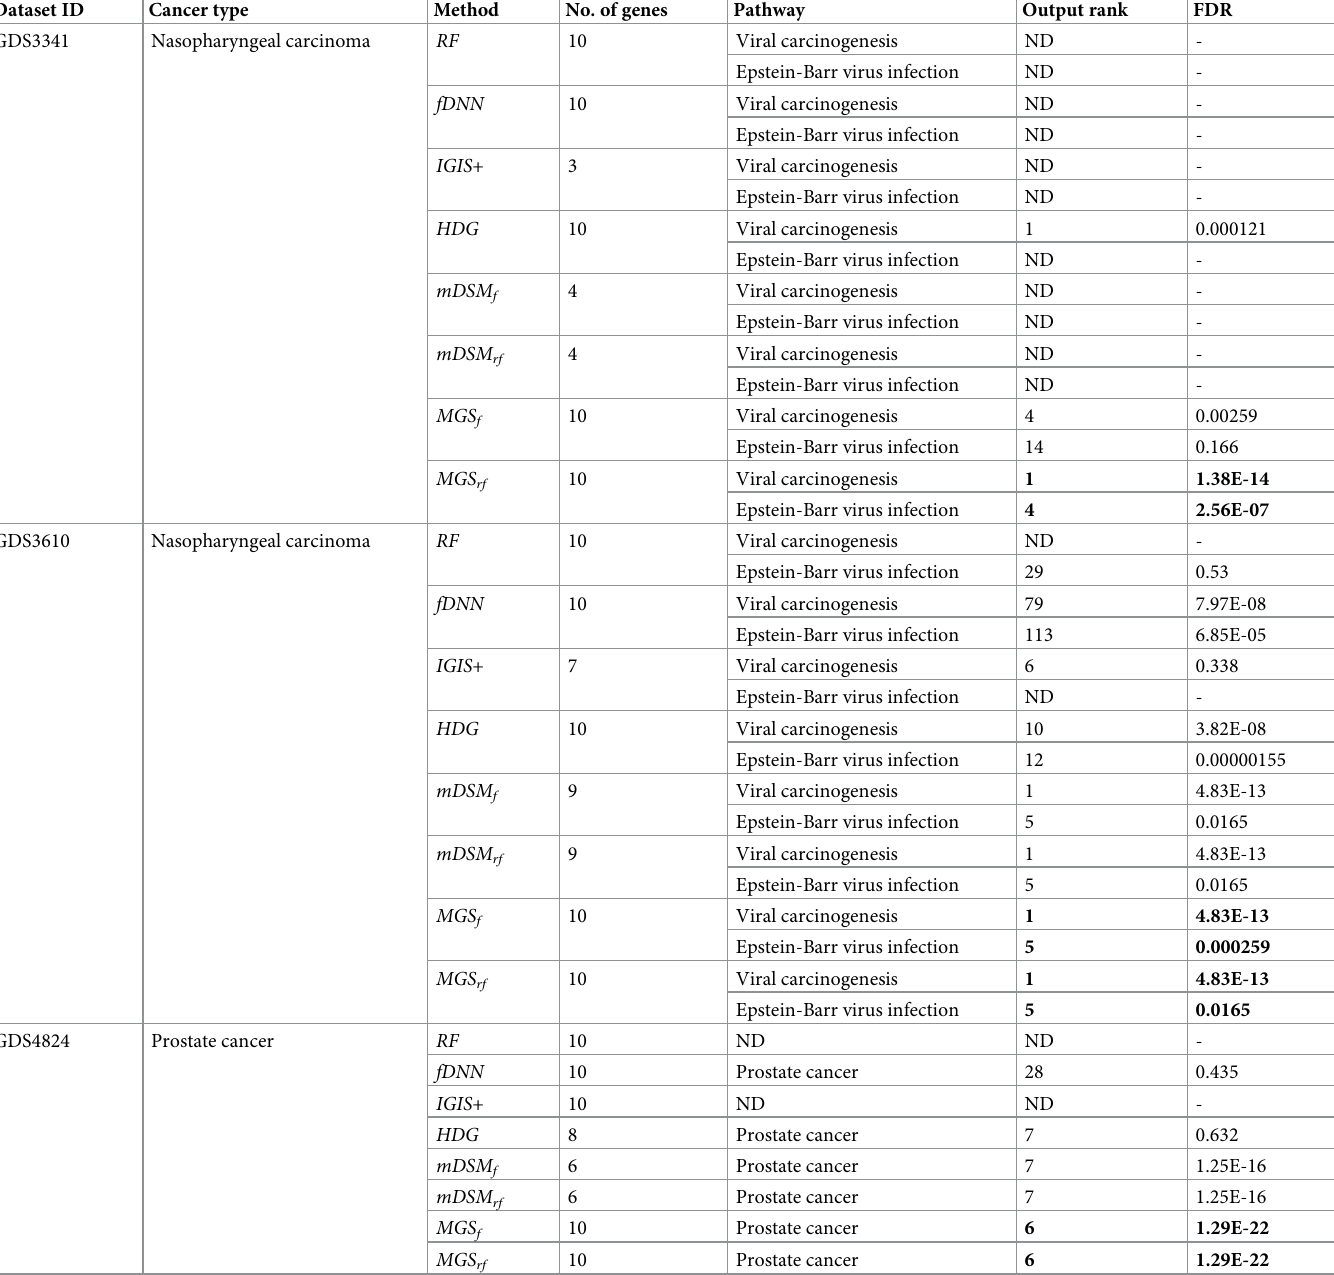
Table 6. Comparative performance of different methods in identification of relevant biological pathways for imbalanced datasets. Dataset